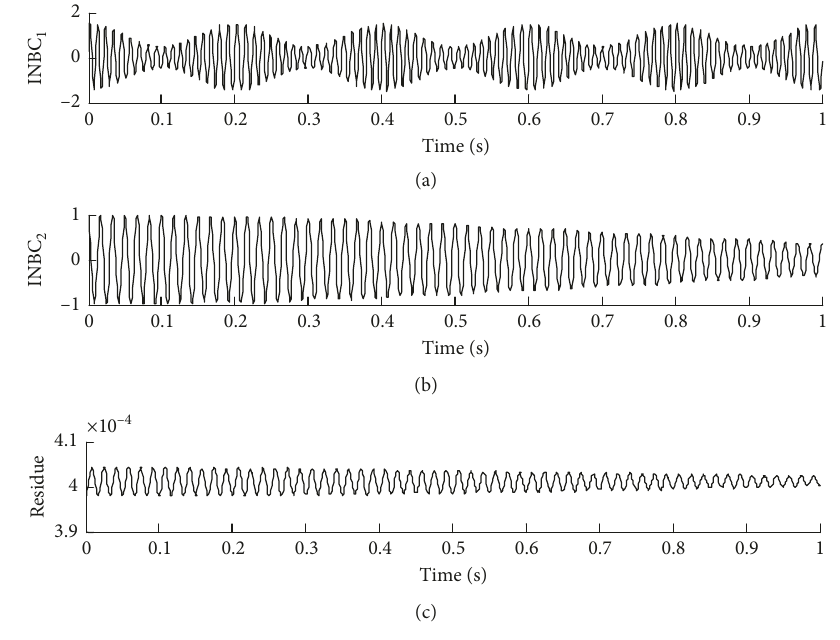
Figure 4: The decomposition results of x